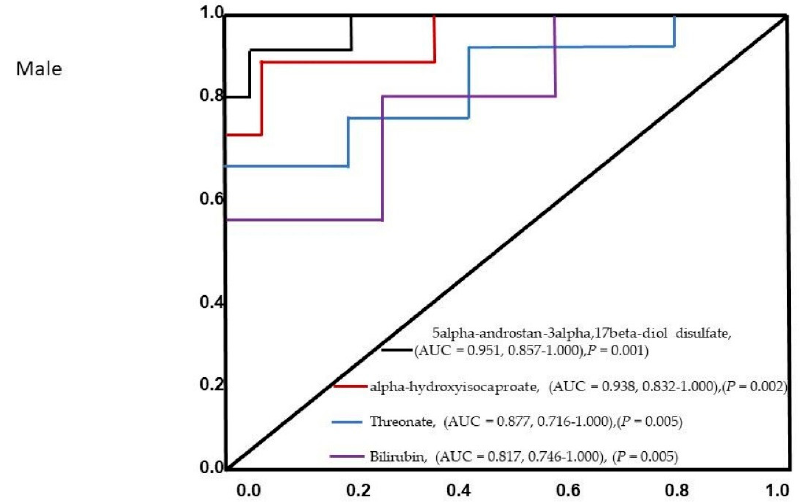
Figure 6. The ROC analysis results from the four diagnostic models calculated from the logistic regression analysis for male patients. The performance of each biomarker model was evaluated by the area under the ROC curve (AUC) and the determination of sensitivity and specificity at the optimal cut-off point defined by the minimum distance to the top-left corner.